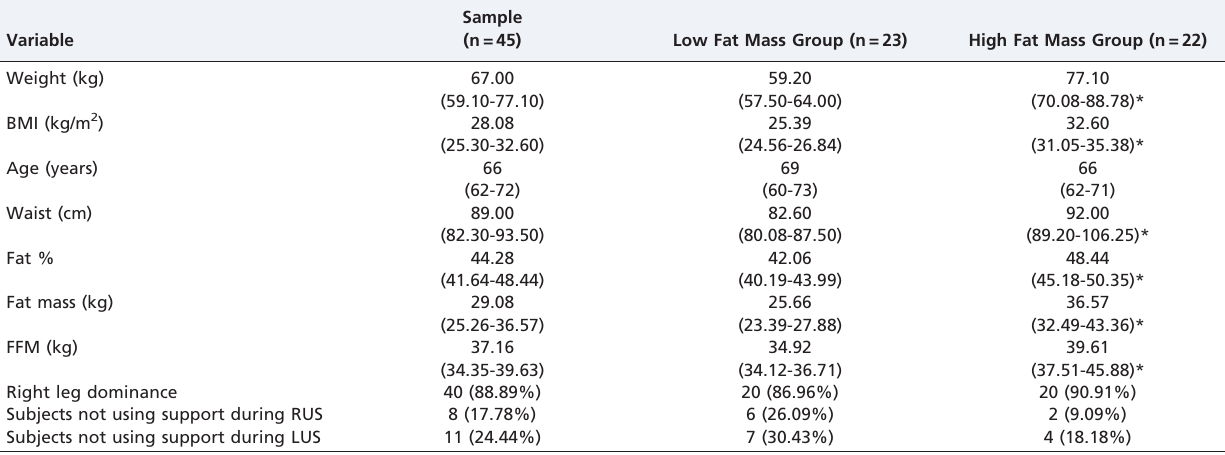
Table 1 - Anthropometric characteristics of the studied sample.